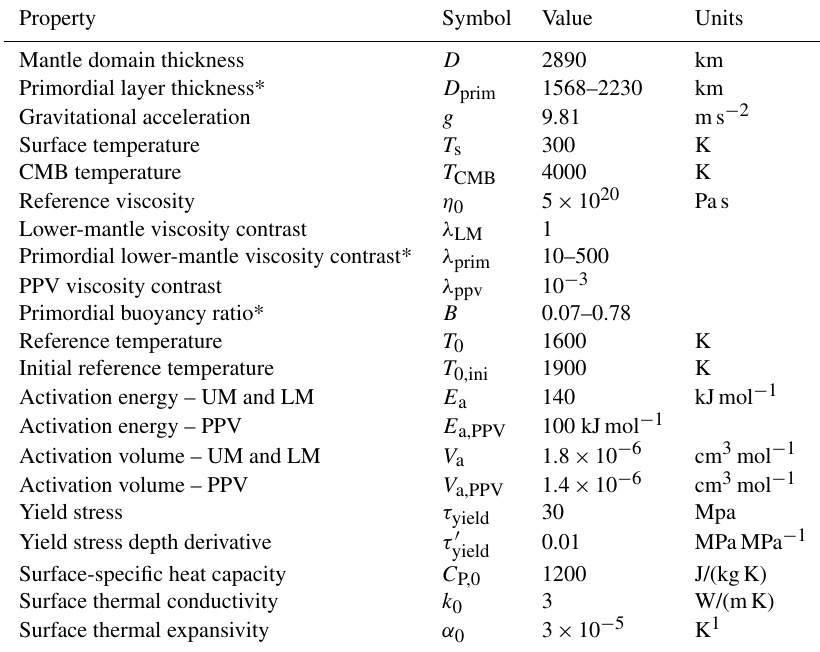
Table 1. A summary of the physical properties used in the numerical simulations of this study. UM stands for upper mantle, LM stands for lower mantle, and PPV stands for post-perovskite. As we solve for compressible convection, the adiabatic temperature, thermal conductivity, thermal expansivity, density, and heat capacity are pressure dependent, following a third-order Birch–Murnaghan equation of state (Tackley et al., 2013). The asterisk (*) notes the parameters that are varied between the models. Property Symbol Value Units Mantle domain